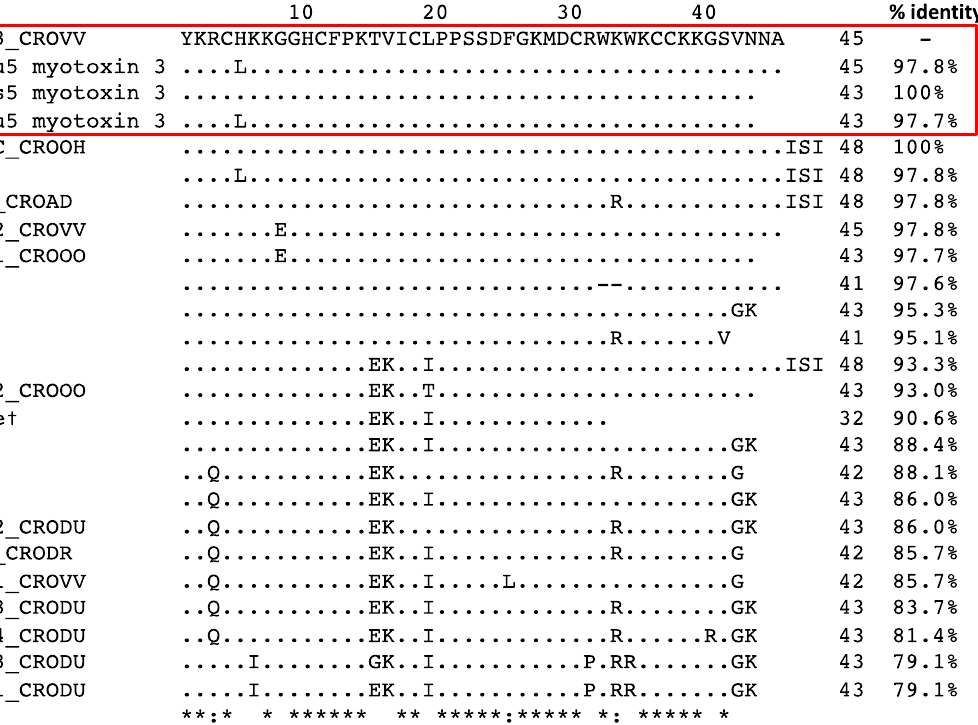
Figure 3. Alignment of the amino acid sequence of myotoxin-3 with homologous peptides. The amino acid sequences from this paper are in a red box. †: Salazar et al . 2020 (ref. [15]). The other sequences were obtained from the UniProtKB/SwissProt database. Dots indicate identities to myotoxin-3 (P63176|MYX3_CROVV), asterisks (*) indicate identical amino acid residues and the symbols “:” indicate conserved substitutions.